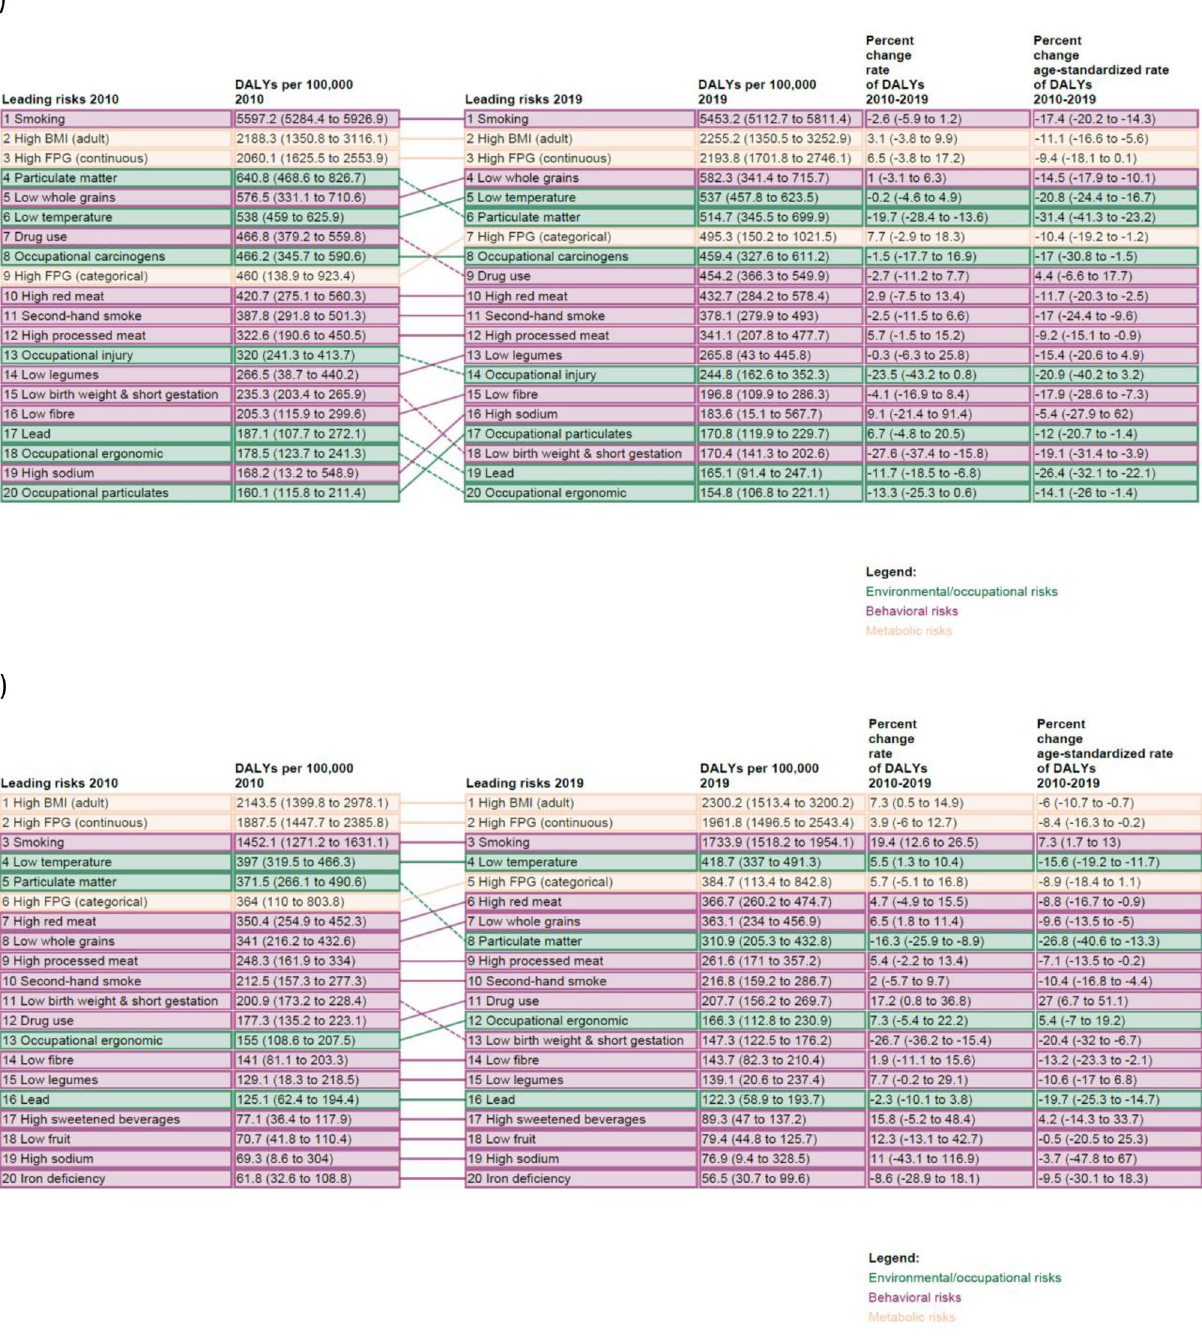
Figure 3. Changes in the rank of risk factors from 2010 to 2019 attributable to disability-adjusted life years (DALYs) in: ( a ) males; and ( b ) females. BMI, body mass index; FPG, fasting plasma